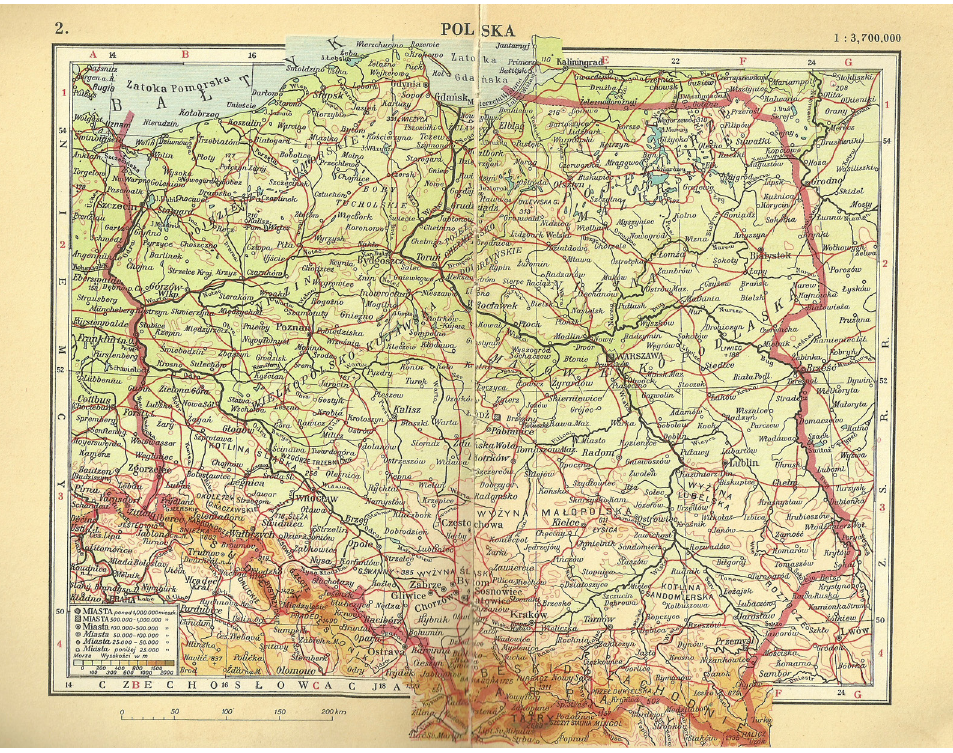
Fig. 4. The map of Poland from Atlas kieszonkowy (The pocket atlas) by K. Kuchař and J.